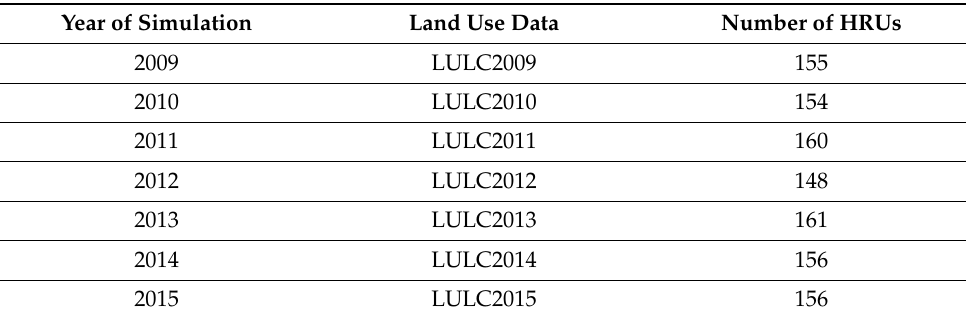
Table 4. Number of HRU changes with the annual LULC